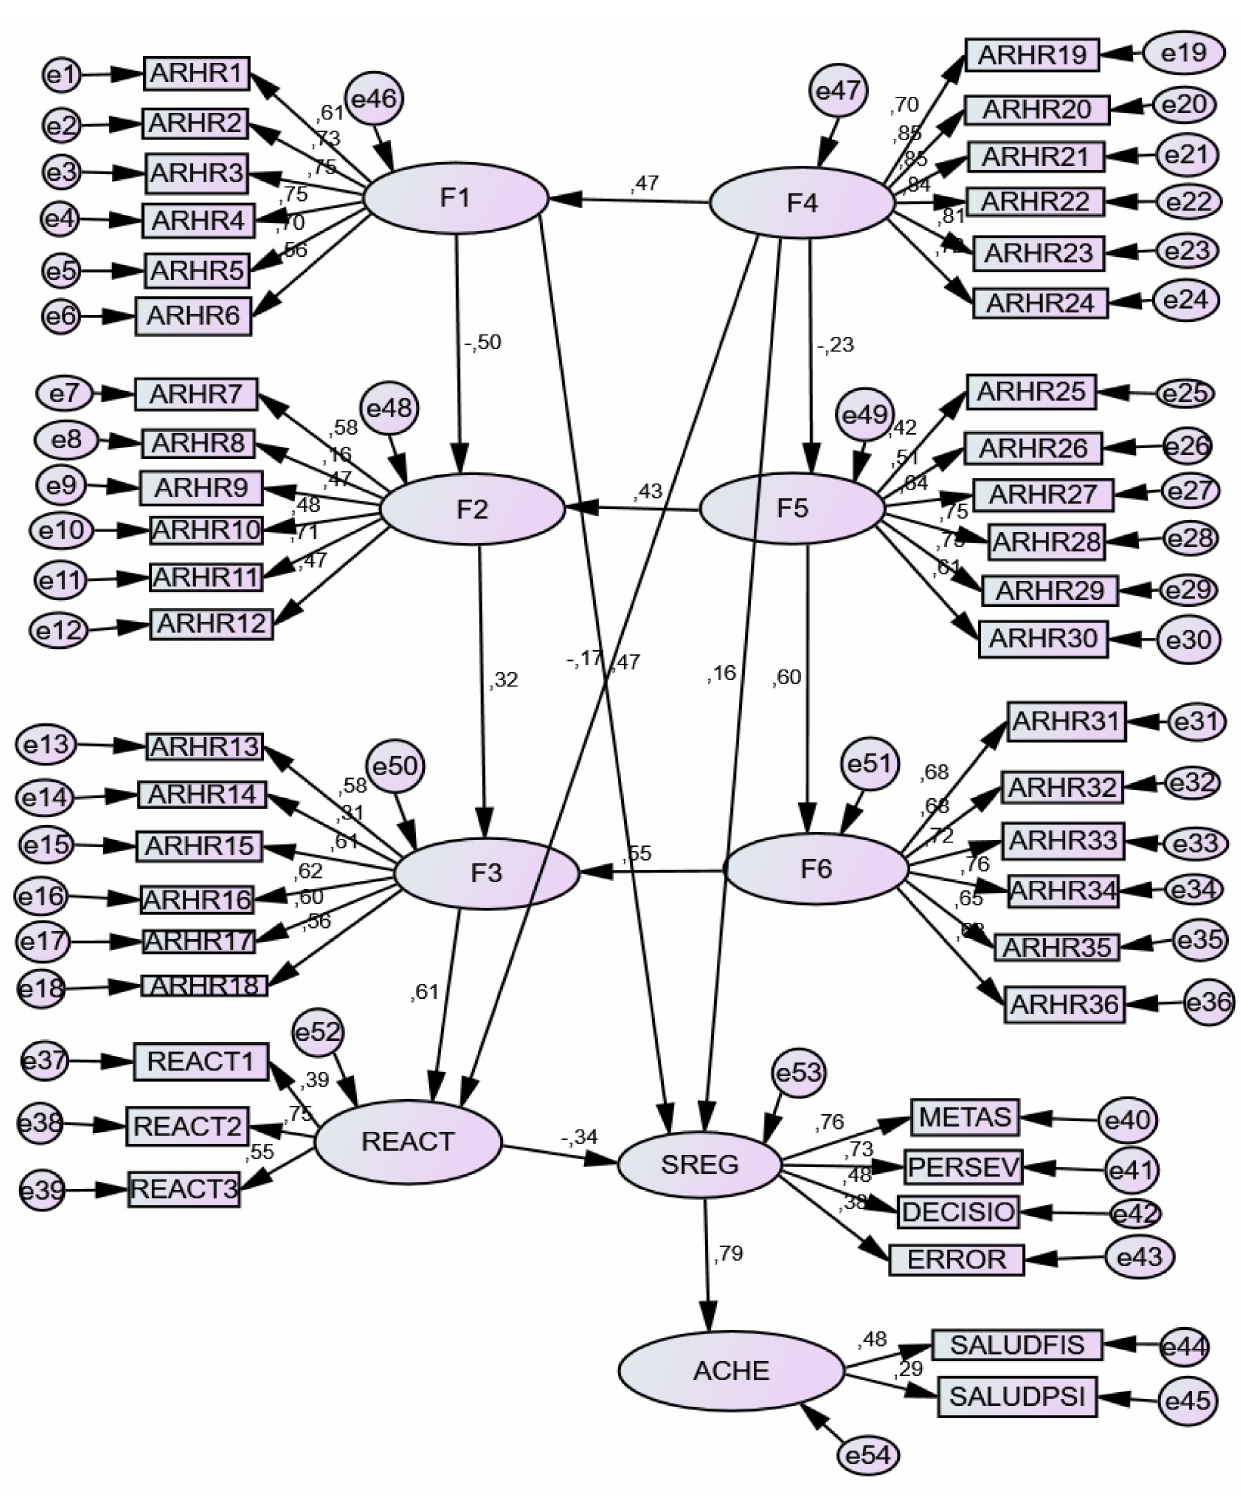
Figure 1. Structural Equations Model of prediction. F1 = Self-Regulation of Health; F2 = Self Non-Regulation of Health; F3 = Self Dys-Regulation of Health; F4 = External Regulation of Health; F5 = External Nonregulation of Health; F6 = External Dysregulation of Health; SR = Self-regulation of general behavior; REACT = Reactance; ACHE = Student Health; ARHR = items of SRH vs. ERH questionnaire; METAS = Goals; PERSEV = Perseverance; DECISIO = Decisions; ER- ROR = Learning from mistakes; REACT = Factors of reactivity: SALUDFIS = Physical health; SALUDPSI = Psychological